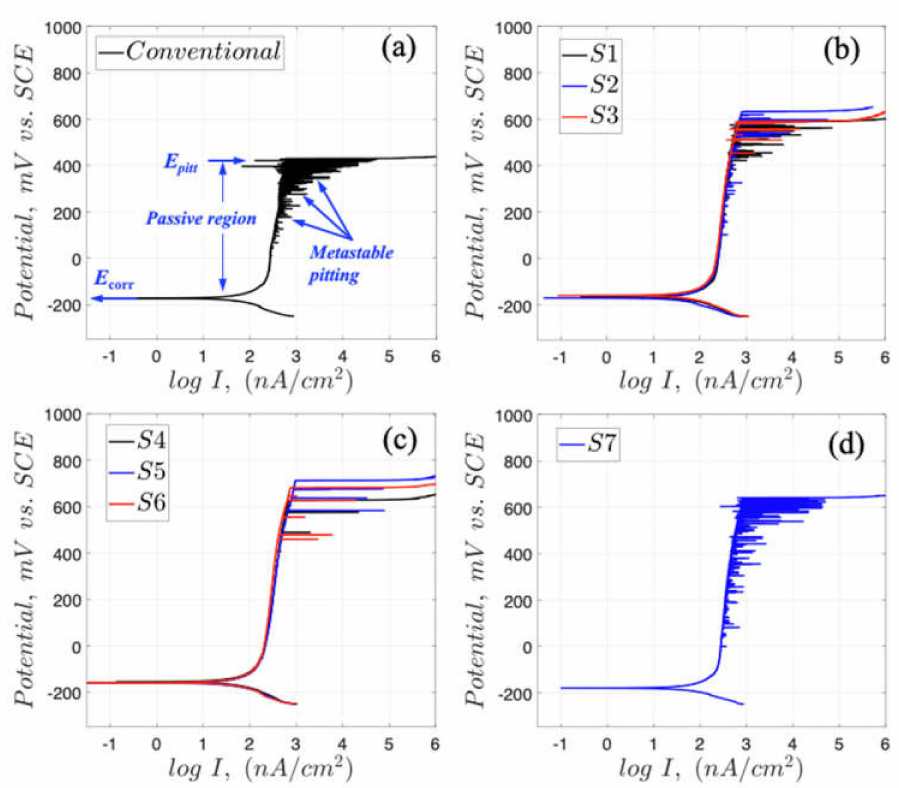
Figure 1. ( a ) Potentiodynamic polarization (PP) curves of the conventional sample, PP curves of the LPBF 316L SS at ( b ) H = 90 µ m (S1–S3) and ( c ) H = 50 µ m (S4–S6) with an increasing laser power from 150 W to 240 W; ( d ) PP curves of sample 7 not showing inferior corrosion property. Unless labeled otherwise, the electrochemical test was conducted on the XY plane (horizontal